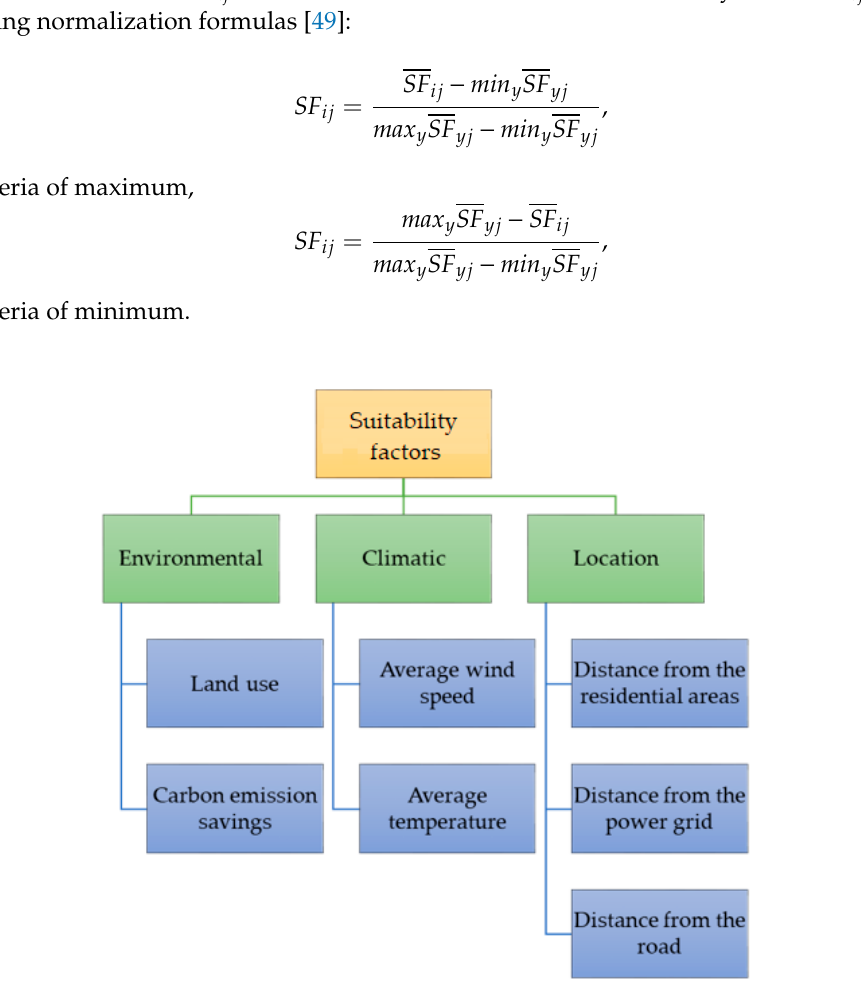
Figure 6. The hierarchy representation of suitability factors.